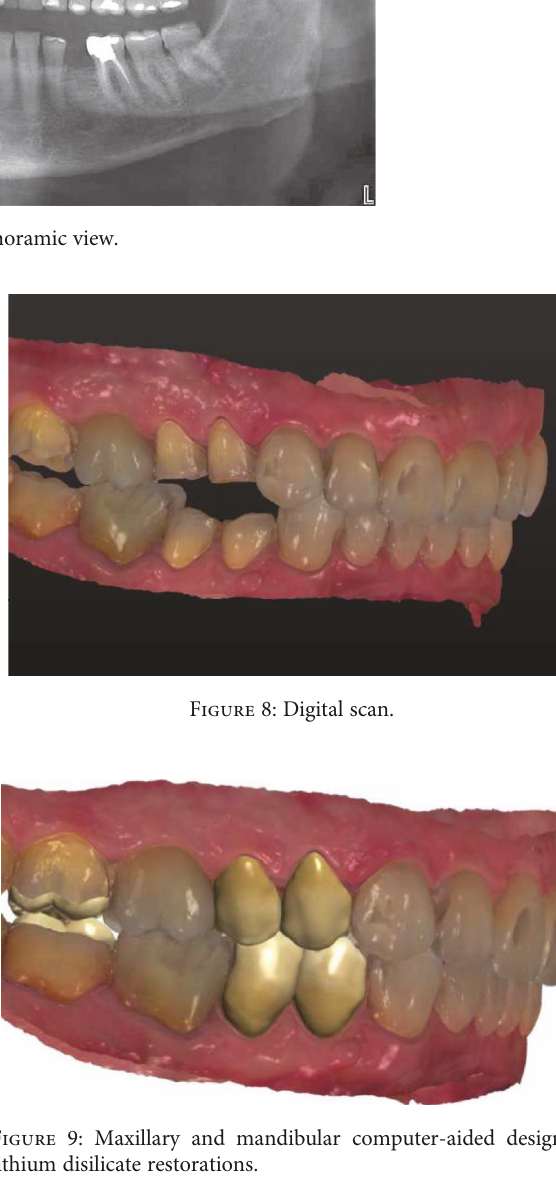
Figure 7: Mandibular occlusal view after initial cementation.